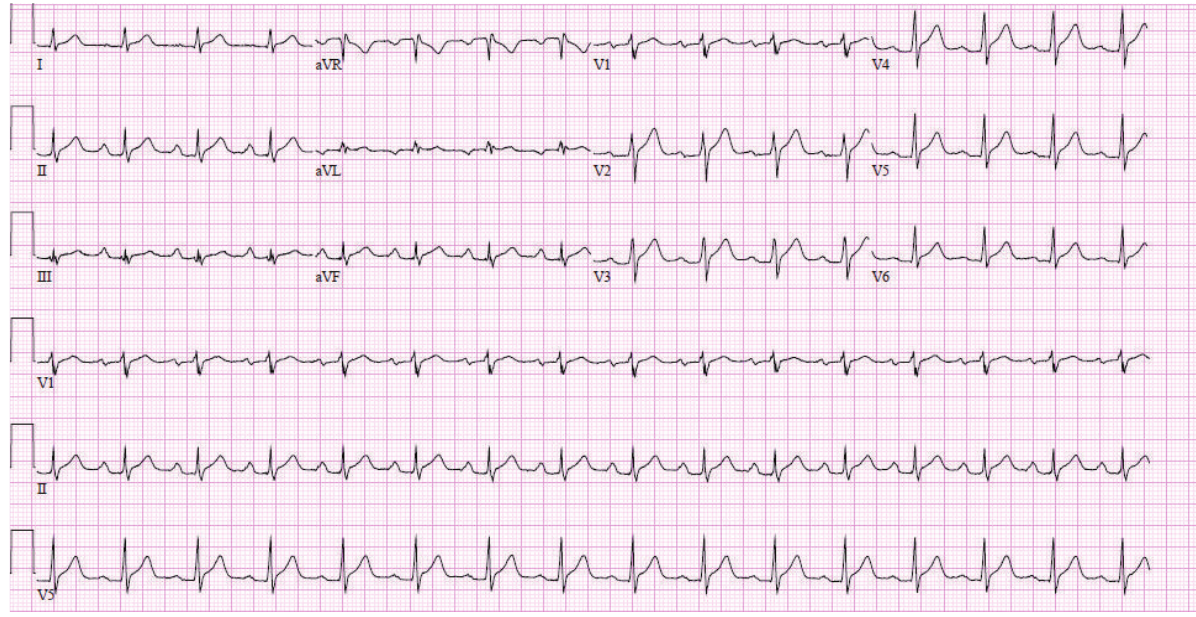
Figure 1: Sinus tachycardia and diffuse ST segment elevation suggestive of early